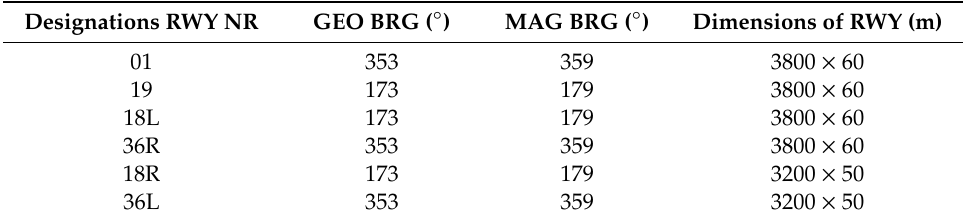
Table 1. The detailed information of runways in